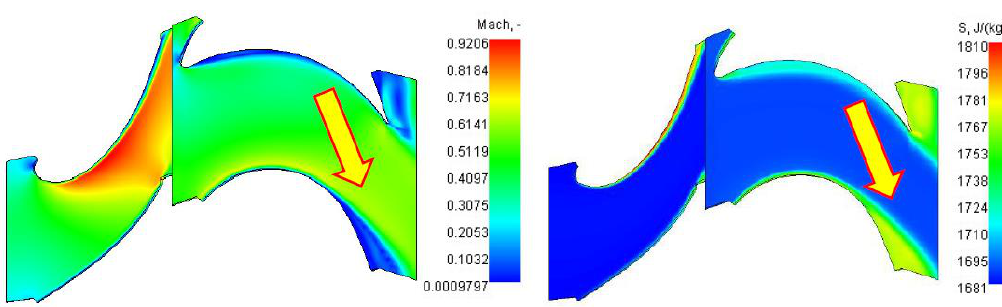
Figure 32. Mach number and entropy contours (85% spanwise).